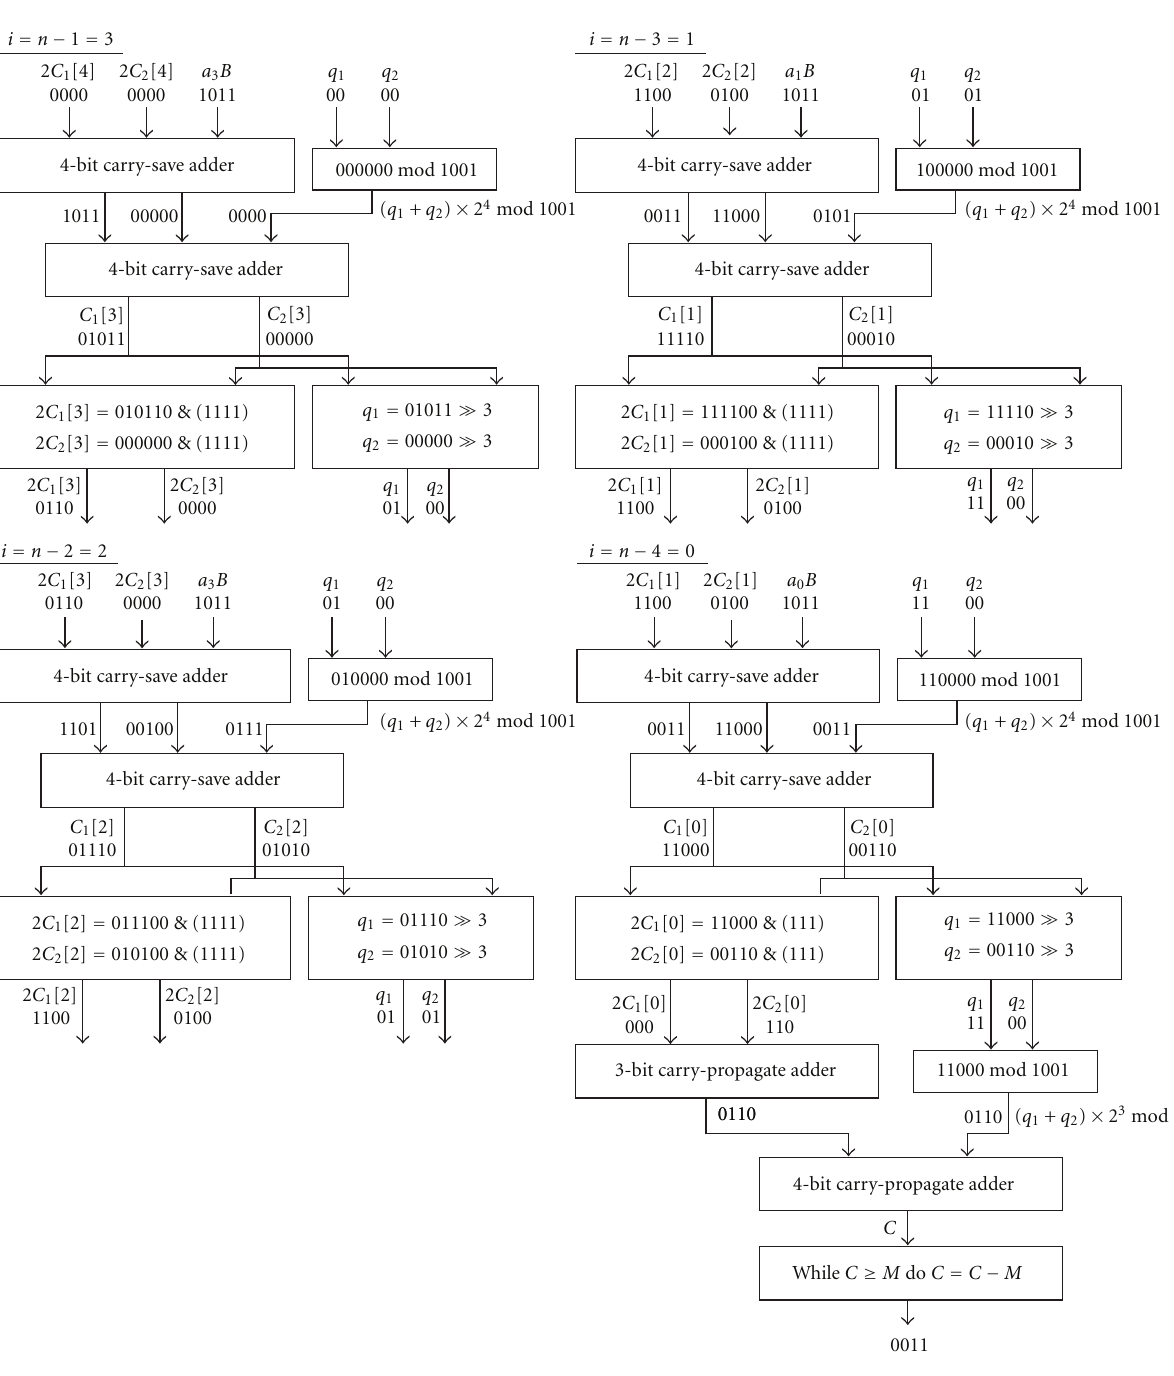
, B = (1011) , and M = (1001) 2 2